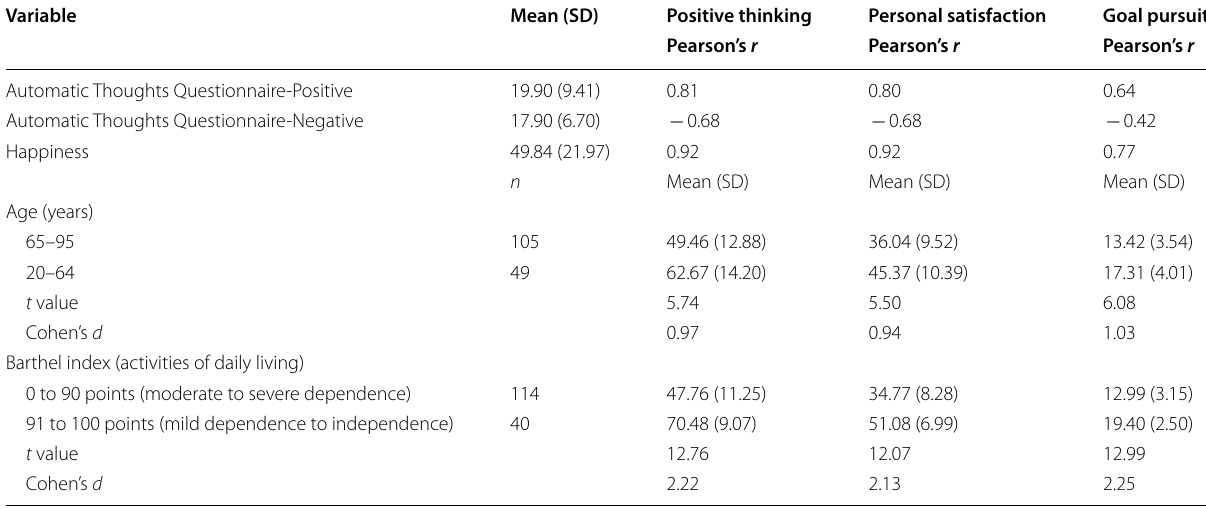
Table 4 Correlation and difference between scale scores ( n